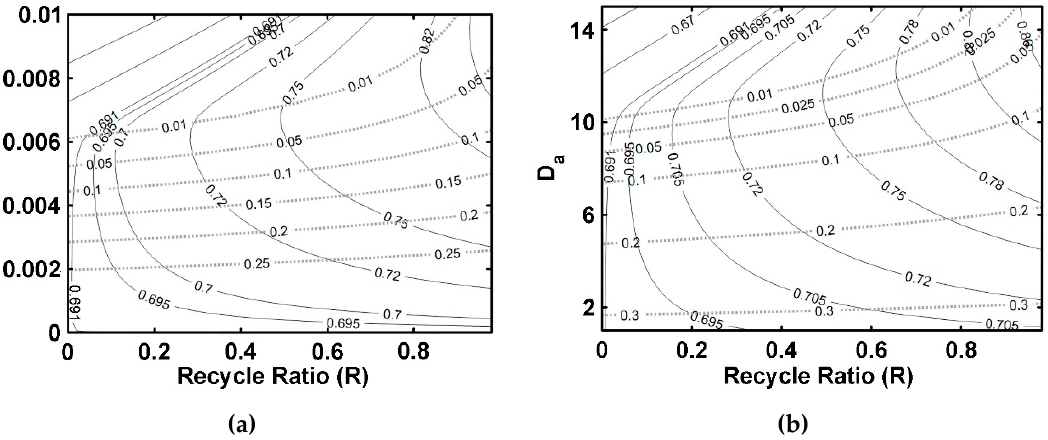
Figure 11. FBR+PVMU ( Configuration 1 ) simulation charts: ( a ) D a = 12 (left side), ( b ) Ω = 0.008. Notes: (i) Ester yields: continuous lines, (ii) Retentate water molar fractions: dashed lines.